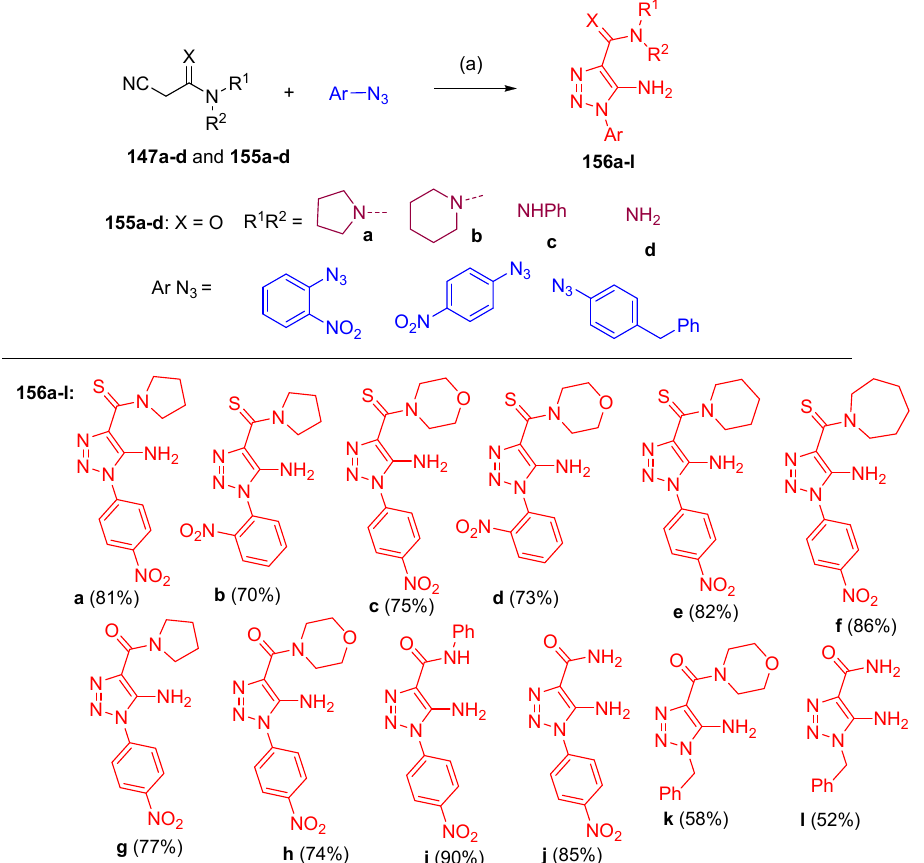
Scheme 63. Synthesis of triazoles 156a – l . Reagents and conditions : (a) NaOH, H 2 O, 50–60 °C.